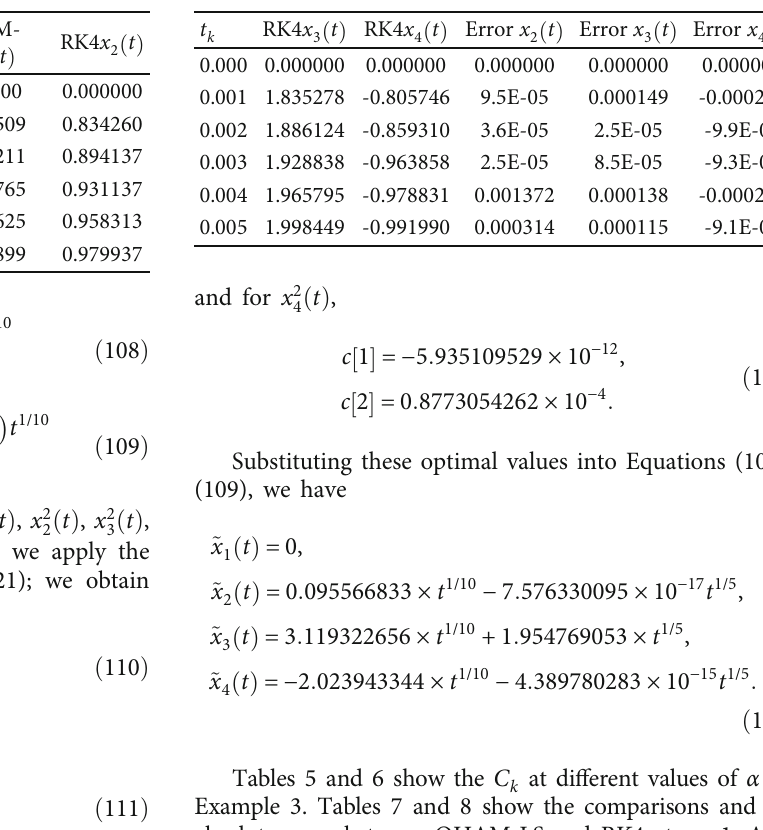
Table 8: Comparison and absolute error between OHAM-LS and RK4, α = 1